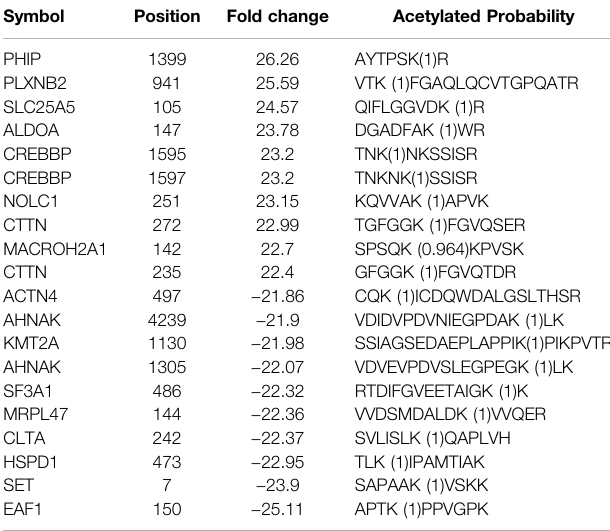
TABLE 1 | Top ten acetylated sites and corresponding proteins with the highest fold changes in acetylome upon SAHA treatment in 5 – 8 F cells. Symbol Position Fold